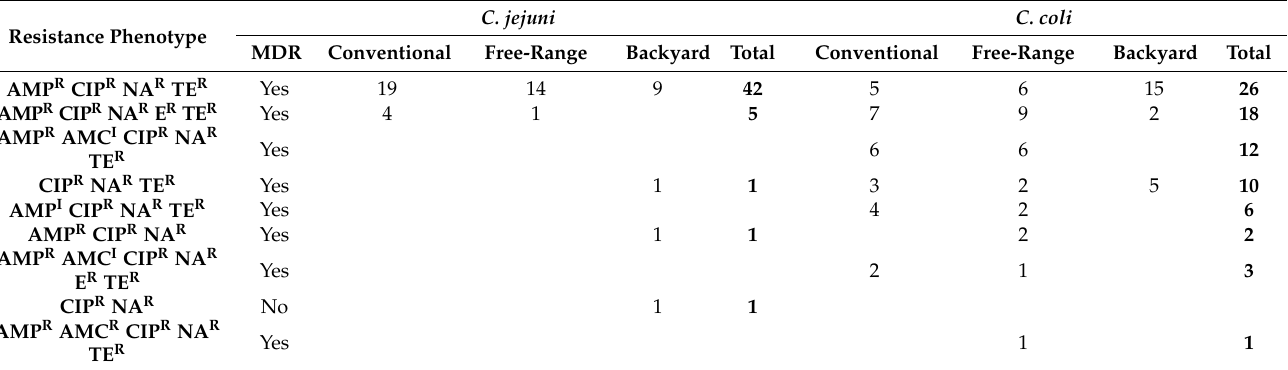
Table 4. Distribution of resistance phenotypes among C. jejuni and C. coli